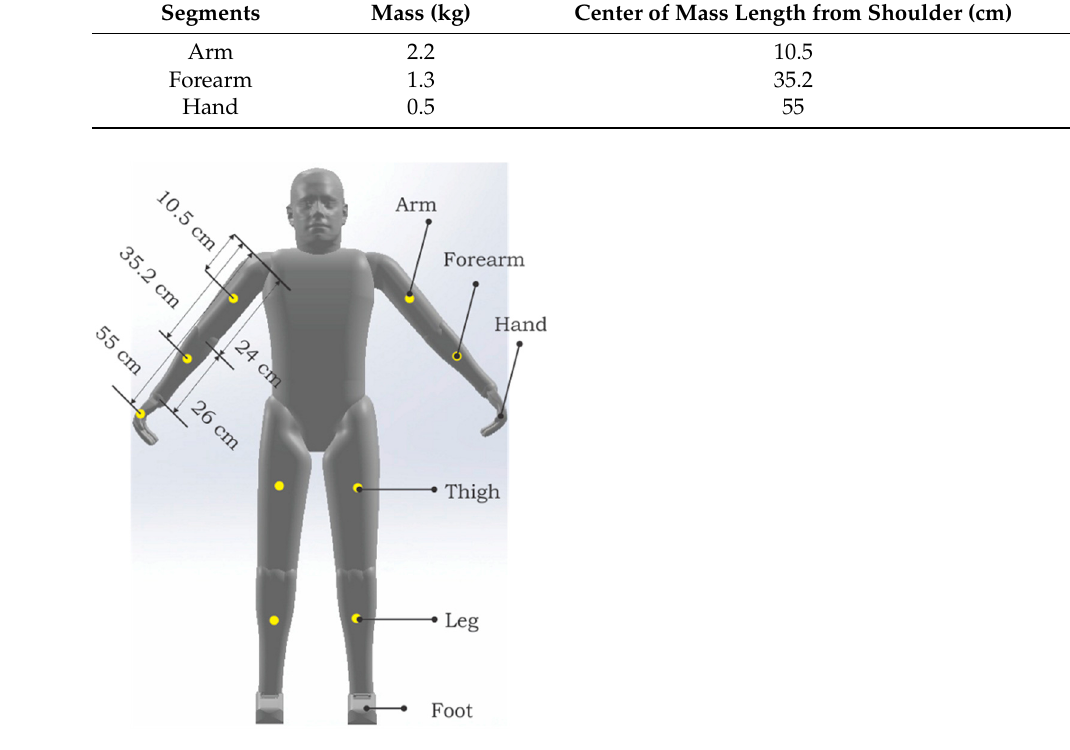
Figure 4. Length and center ‐ of ‐ mass location of the upper limb segments.